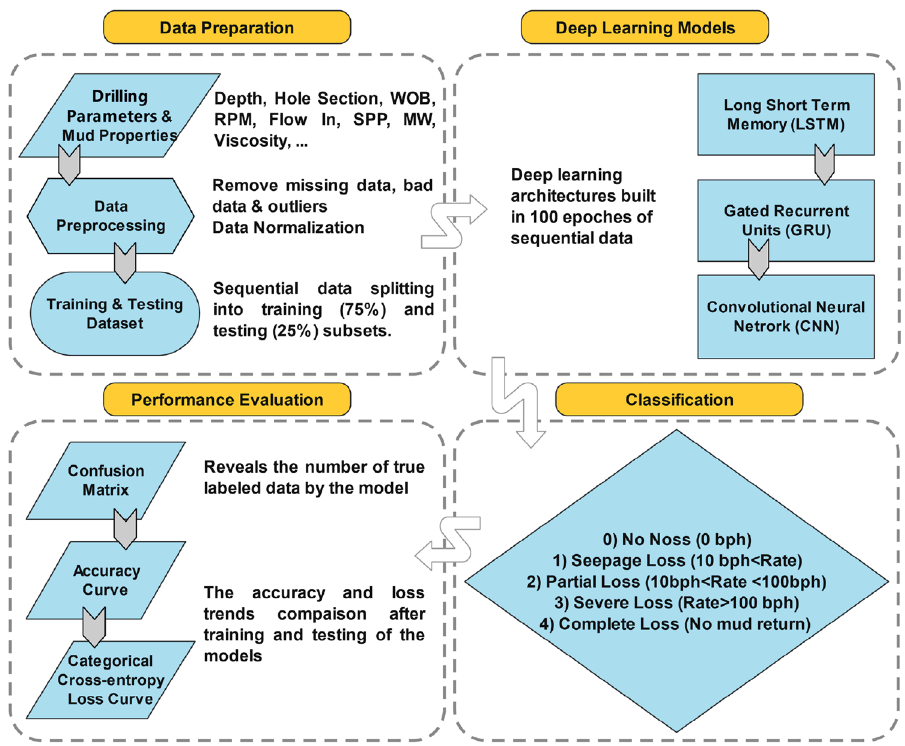
Fig. 3 Lost circulation classifi- cation